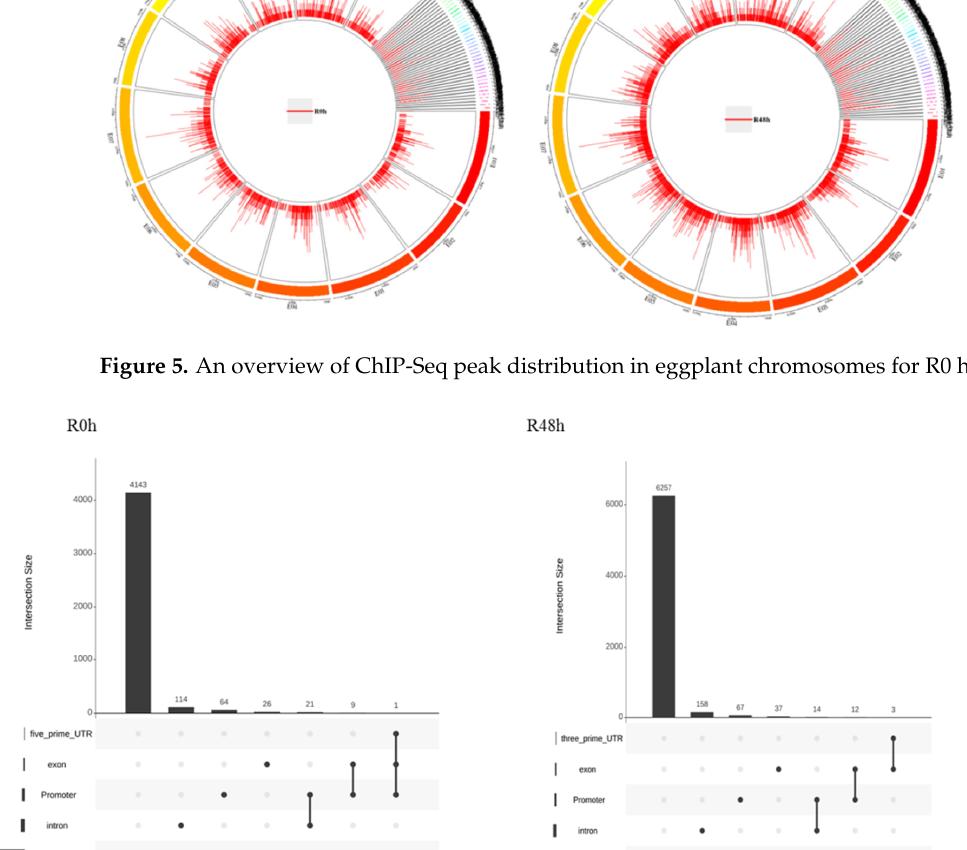
Figure 5. An overview of ChIP-Seq peak distribution in eggplant chromosomes for R0h and R48h.